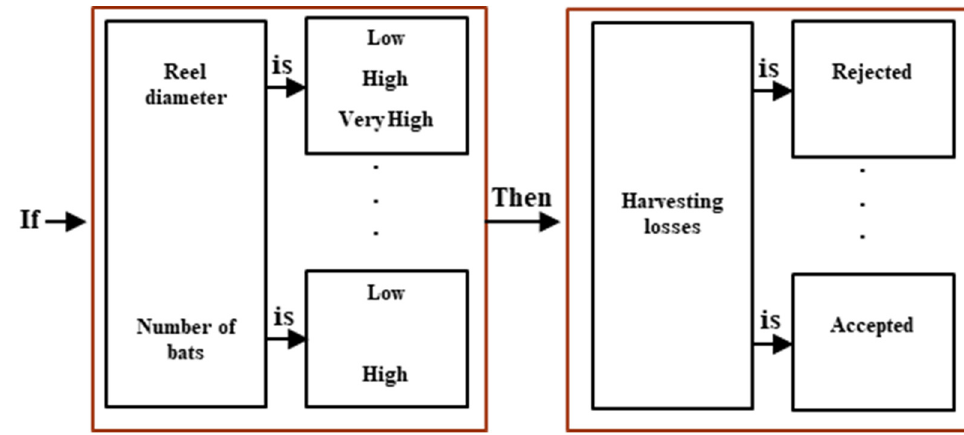
Figure 4. The set if–then conditions to establish the rule-base of the fuzzy system.